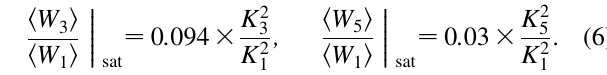
FIG. 3. Ratio of coupling factors, (cid:1) K line) and the 5th (dashed line) harmonics with respect to the fundamental harmonic versus rms value of undulator parameter K . rms